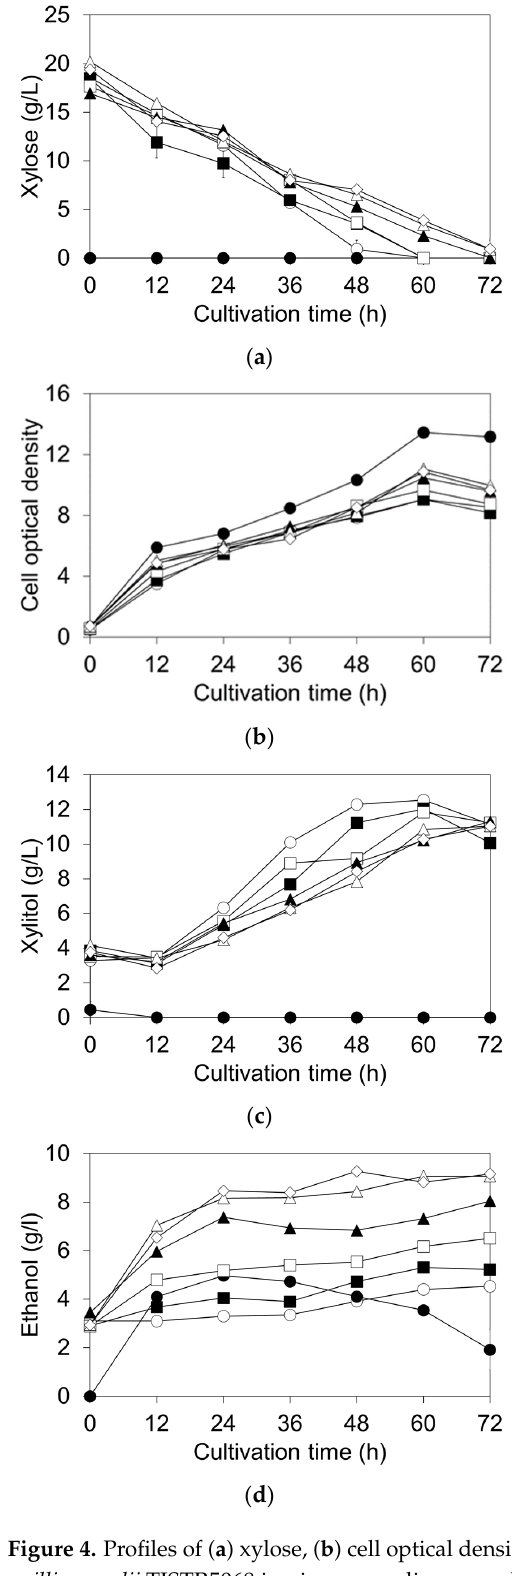
Figure 4. Profiles of ( a ) xylose, ( b ) cell optical density, ( c ) xylitol, and ( d ) ethanol when cultivating C. guilliermondii TISTR5068 in vinasse medium supplemented with various molasses concentrations at 30 ◦ C, 200 rpm for 72 h. Figure 3. Profiles of ( a ) xylose, ( b ) cell optical density, and ( c ) xylitol for cultivated C. guilliermondii TISTR5068 in vinasse medium at 30 °C and various aeration patterns for 72 h .  —no aeration, 100 Table 2. Parameters from xylitol fermentation by C. guilliermondii using vinasse supplement by 1 g/L of yeast extract cultivated at different dissolved oxygen levels for 72 h. Xylitol * Q p * Xylose Aeration Used (%) Conditions ( g / L ) ( g / L . h